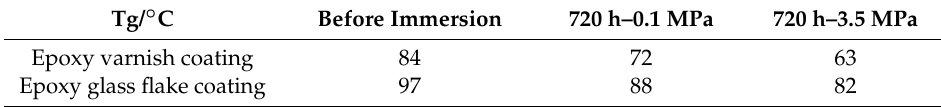
Table 1. The glass transition temperatures of the coatings before and after immersion.